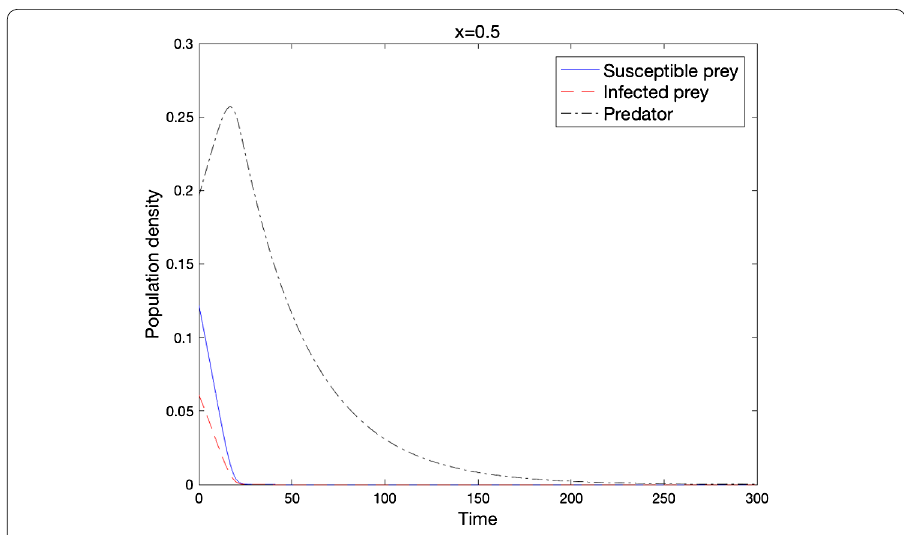
Figure 1 Local stability of e 0 when the condition of Theorem 2.4 holds ( d = 0.01, D = 0.01, r = 0.05, b = 0.430, d 1 = 0.03, d 2 = 0.6, K = 1.0, α = 1.2, β = α , c = 1.0, m =